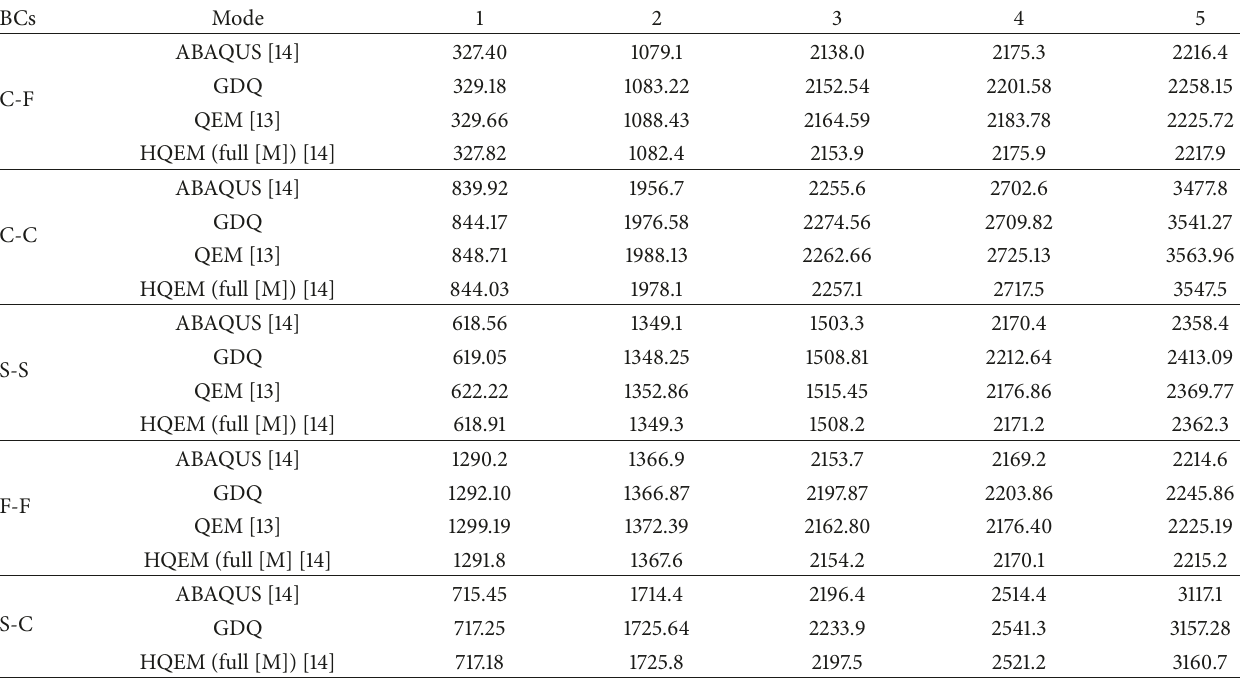
Table 3: The five low natural frequencies for different boundary conditions (Hz).